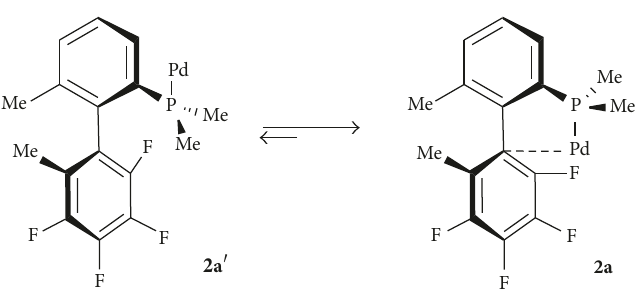
Figure 2: “Cyclic” ( 2a ) and “extended” ( 2a 󸀠 ) conformations of the fluorinated C,P -complex.